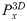
Plane approximation for 2D distance map computation.(A) The red point shows the position of the voxel x for which the plane approximation should be computed. The mineralized cartilage (foreground) is shown as transparent surface. (B) Rays starting from x and intersection points Px3D. (C) Rotated view showing the best fitting plane Hx (green) for the points shown in (B). The mineralized cartilage has been cut in order to visualize the orientation of the plane.